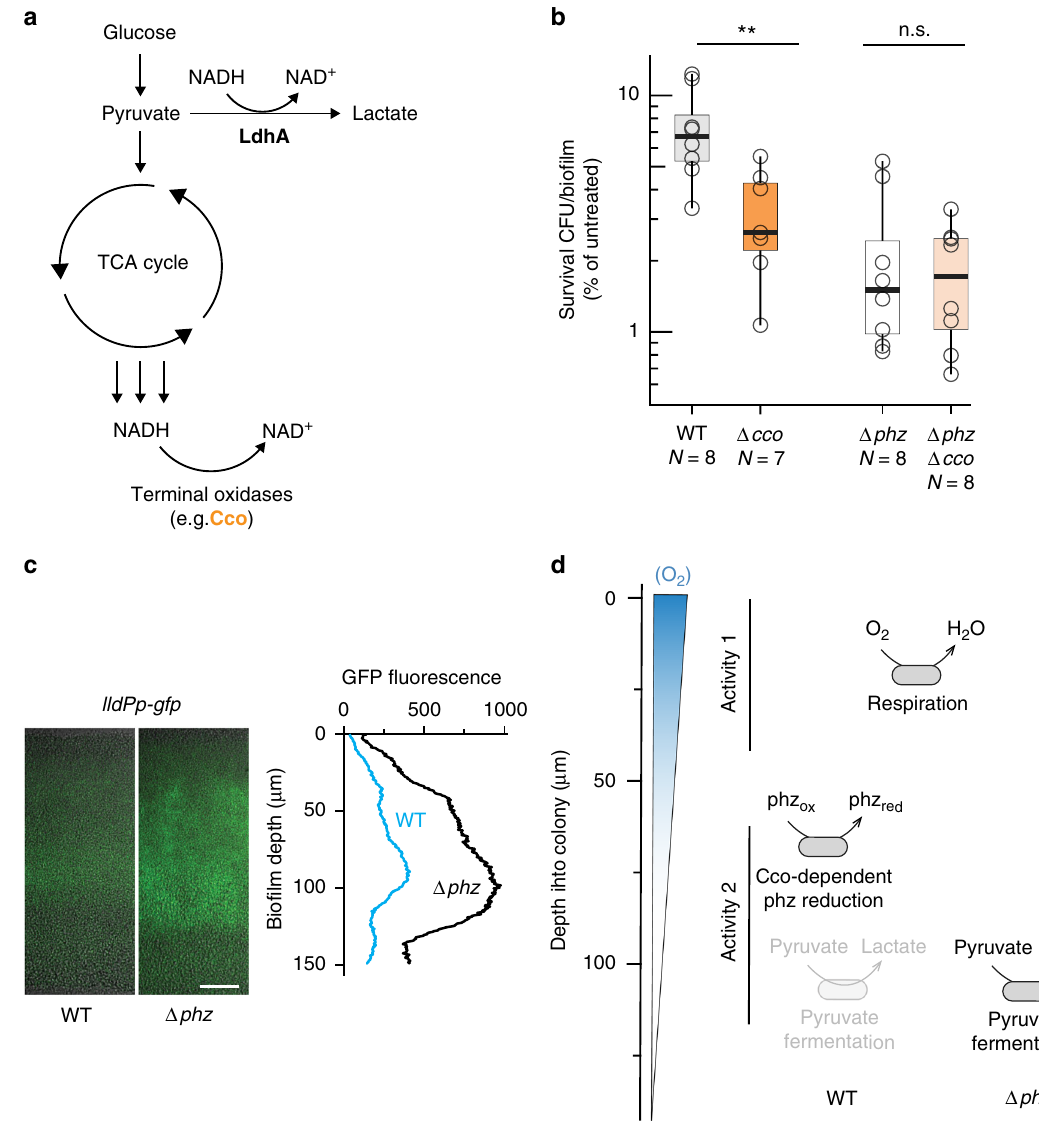
Fig. 4 Analyses of antibiotic sensitivity and gene expression indicate that diverse redox-balancing pathways are functioning in PA14 bio fi lms. a Overview of the redox-balancing pathways investigated. NADH can be re-oxidized by pyruvate fermentation via LdhA or by the electron transport chain via terminal oxidases, such as the cbb 3 -type Cco complexes implicated in phenazine reduction. b Cipro fl oxacin (100 µ g/mL) tolerance observed for cells from bio fi lms formed by cco mutants. Data for the parent strains (WT and Δ phz ) are shown in gray. p values are based on an unpaired two-sided t -test between strain pairs as indicated (n.s., not signi fi cant; ** p ≤ 0.01). Data for growth without antibiotics does not show signi fi cant differences between strains (Supplementary Figure 3). The center line of the boxplot shows the median, the lower and upper hinges correspond to the fi rst and third quartiles, and the whiskers extend to the most extreme points, limited to 1.5 times the interquartile range. c Expression analyses of WT and Δ phz colony paraf fi n sections show lactate production (which activates expression of the lldPDE operon) in bio fi lms grown on de fi ned medium with glucose as the sole carbon source. One representative biological replicate is shown (data for all replicates ( N = 3) is shown in Supplementary Figure 9e). Scale bar is 25 µ m. d Model depicting the metabolisms that could support redox balancing in oxic (activity 1) and hypoxic (activity 2) bio fi lm subzones, contributing to activities detected by isotope labeling/SRS imaging and to antibiotic addition, our data suggest that treatment of P. aeruginosa bio fi lm currently the mechanistic basis whereby respiration supports infections is in fl uenced by interactions of antibiotics and phe- cipro fl oxacin tolerance is less clear. nazines, compounds detectable in cystic fi brosis patients 49 . Our Our results represent the fi rst direct visualization of the het- fi ndings thus highlight the interactions between small molecule erogeneous distribution of metabolism inside bio fi lms by in situ metabolites, primary metabolism, and antibiotics that can impact SRS metabolic imaging of stable isotope incorporation. This the survival of microbes that cause bio fi lm-based infections. technique can be generally applied for studying microbial meta- bolism and antibiotic treatment in complex settings with high spatial resolution and minimal perturbation, which is of great importance considering that bio fi lms are one of the main con- tributors to persistent and antibiotic-resistant infections 48 . In